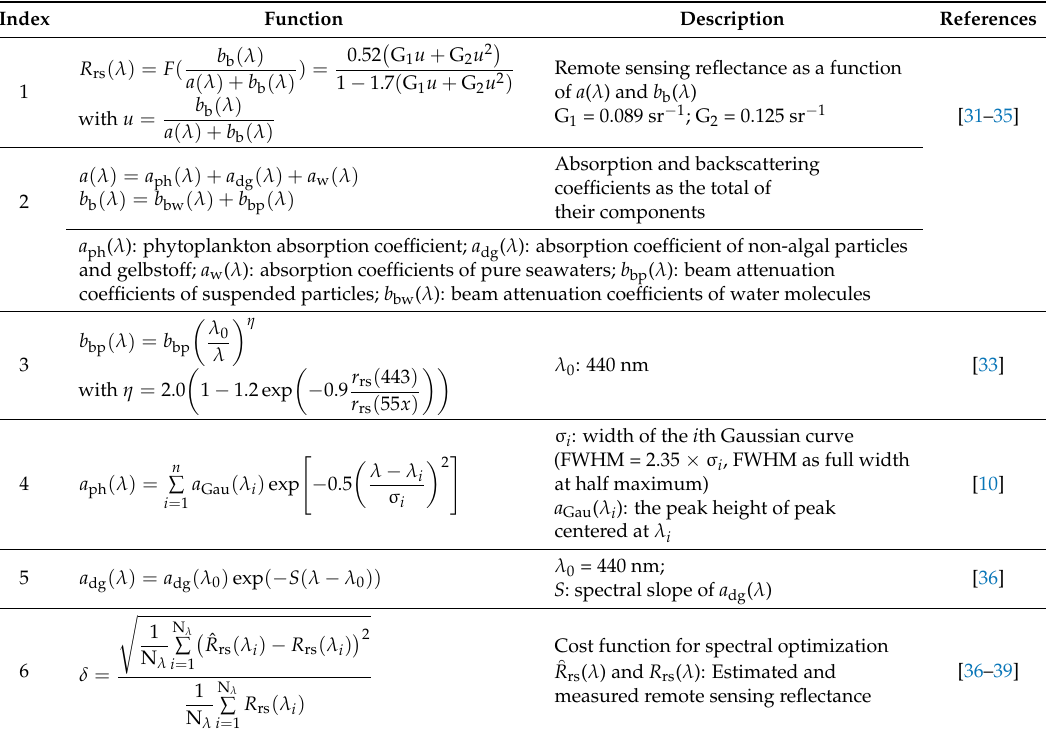
Table 1. Summary of the functions and symbols used in multi-pigment inversion model